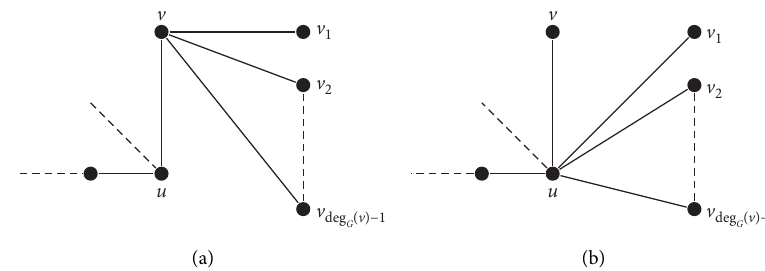
Figure 1: The trees (a) T and (b) T ′ in Transformation 1.